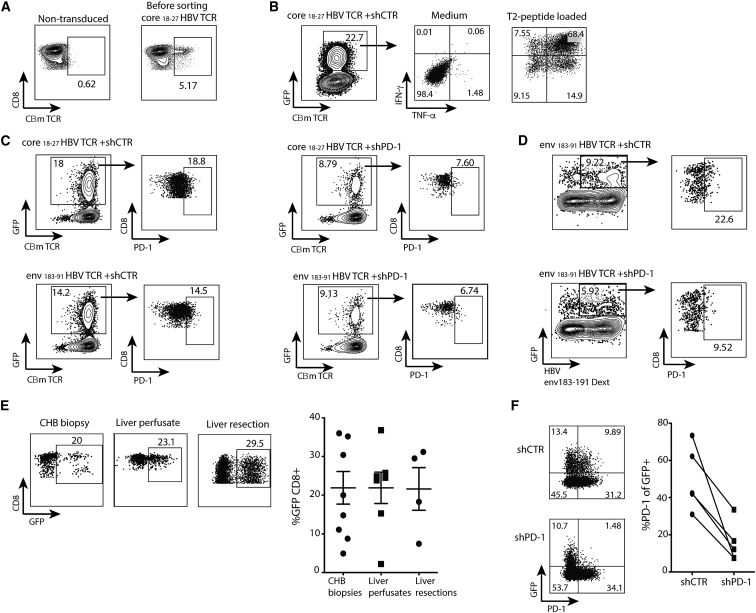
PD-1 Knockdown on HBV TCR-Redirected CD8 T Cells from the Intrahepatic and Peripheral Compartment(A) FACS dot plots showing non-transduced and HBV core18–27TCR CD8 T cells from a healthy donor before sorting. TCR expression was analyzed by the expression of murine Cβ region (CβmTCR). (B) Sorted TCR-redirected CD8 T cells were activated and transduced with LV-shCTR. After 7 days, the frequency of IFN-γ-TNF-α levels gated on GFP+CβmTCR+ was measured after stimulation with HBc18–27 peptide-loaded T2 cells. (C) Representative FACS dot plots of PD-1 expression on GFP+CβmTCR+ CD8 T cells from a healthy donor after transduction of HBV core18–27/env182-191TCR with LV-shCTR or LV-shPD-1. (D) PD-1 levels in GFP+ HBV env183-191TCR-redirected CD8 T cells gated on dextramer+ CD8 cells. Intrahepatic lymphocytes were activated for 24 hr with a cocktail of cytokines and transduced with LV-shCTR. (E) Representative FACS dot plots and summary data of the frequency of intrahepatic GFP+ CD8 T cells. (F) Representative FACS dot plots and summary data of PD-1 expression on intrahepatic CD8 T cells transduced with LV-shCTR or LV-shPD-1 (n = 5). Data were analyzed with Wilcoxon rank-sum test. CD8 T cells were pre-gated on live+/CD3+/CD4−, and in the case of restimulation with peptide-loaded T2 cells or dextramer staining, CD19-positive cells were excluded.